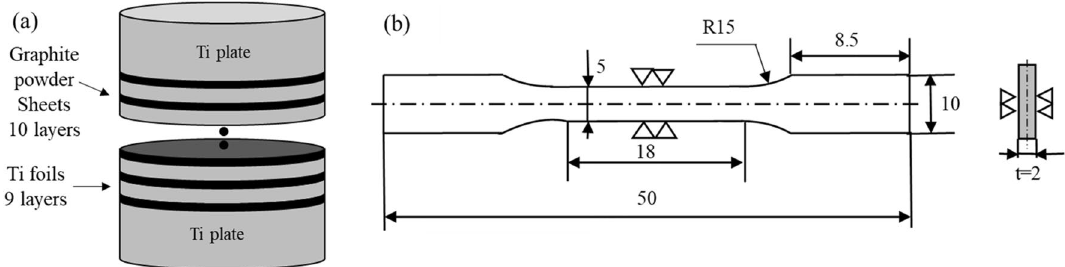
Figure 2. ( a ) Schematic illustrations of preparation processes of large-scale samples; ( b ) Image of shape of tensile specimen (ASTM test method E8M-11, unit: mm).